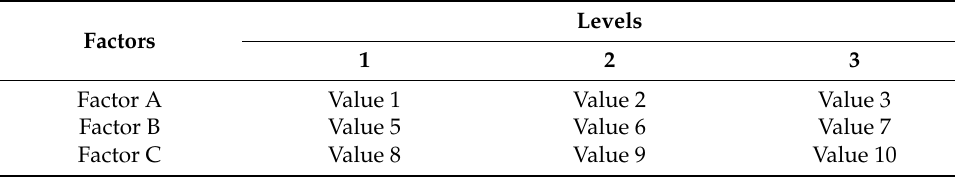
Table 2. Factor-level table (three factors and three